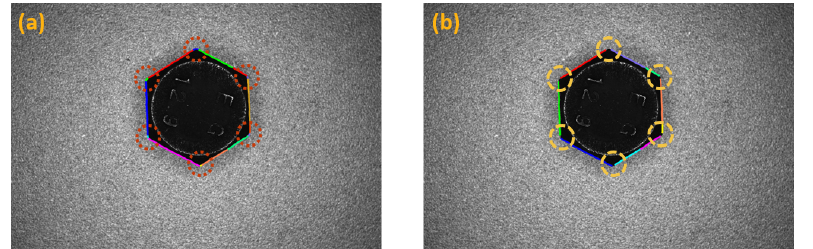
Figure 16. Edges processing of the screw head image. ( a ) Set of lines and curves. ( b ) Hexagonal edges of the screw after the